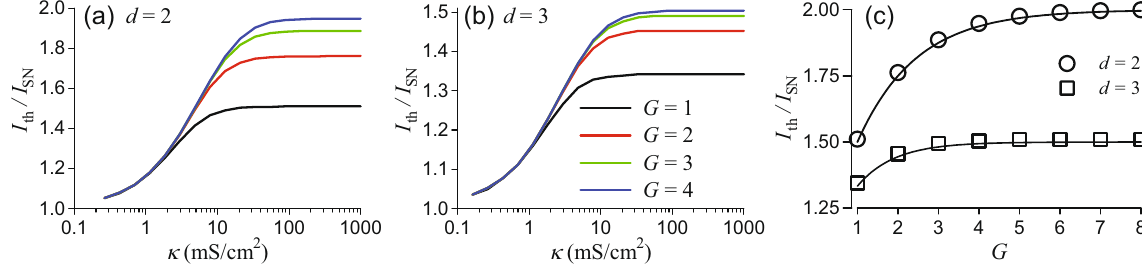
Figure 2. Threshold constant current, I th , which gives rise to repetitive APs at the central node of a tree network with branching d and number of generation, G . The threshold current is normalized by the bifurcation value I SN = 28.15 μ A/cm 2 at which a single isolated HH node starts to generate a periodic sequence of APs. ( a,b ): Threshold current vs the coupling strength, κ , for the indicated number of generations, G (see legend on panel b) and the branching, d = 2 ( a ) and d = 3 ( b ), respectively. ( c ): Threshold constant current resulting from simulations (symbols) vs the number of generations for strong coupling κ = 100 mS/cm 2 and indicated values of branching, d . Solid lines show the scaling relation